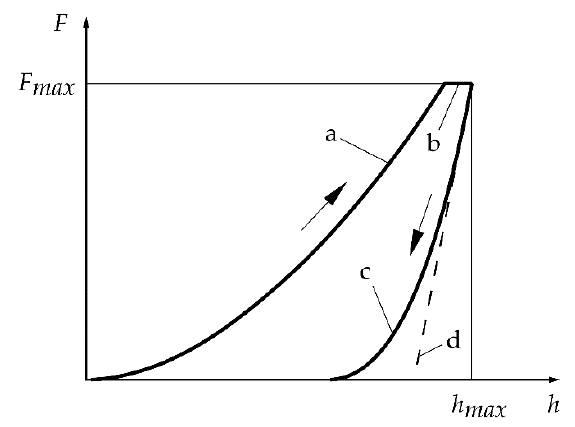
Figure 1. Exemplary load-displacement curve of an instrumented microindentation test: application of test force, a ; creep at test force, b ; decrease of test force, c ; tangent to curve c at 𝐹 𝑚𝑎𝑥 , d .